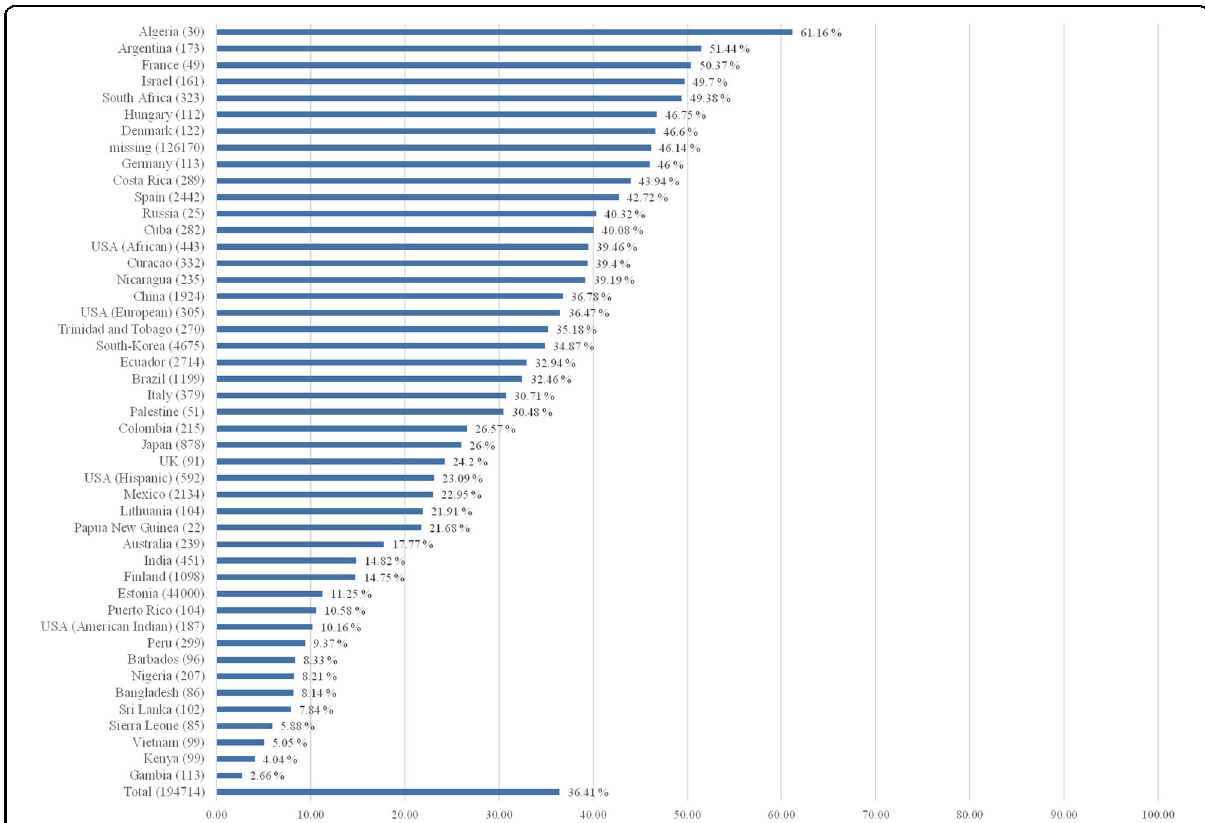
Fig. 2 CYP2D6 non-normal probability estimate per country. Country (genotyped subjects); non-normal probability estimate in